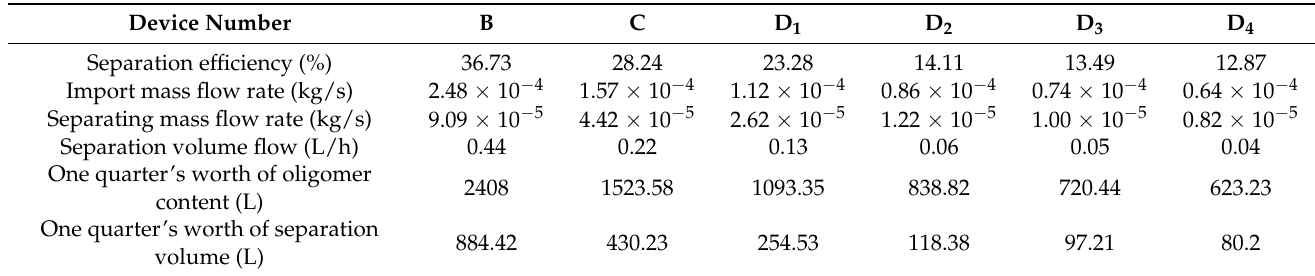
Table 3. Separation conditions of the cyclone